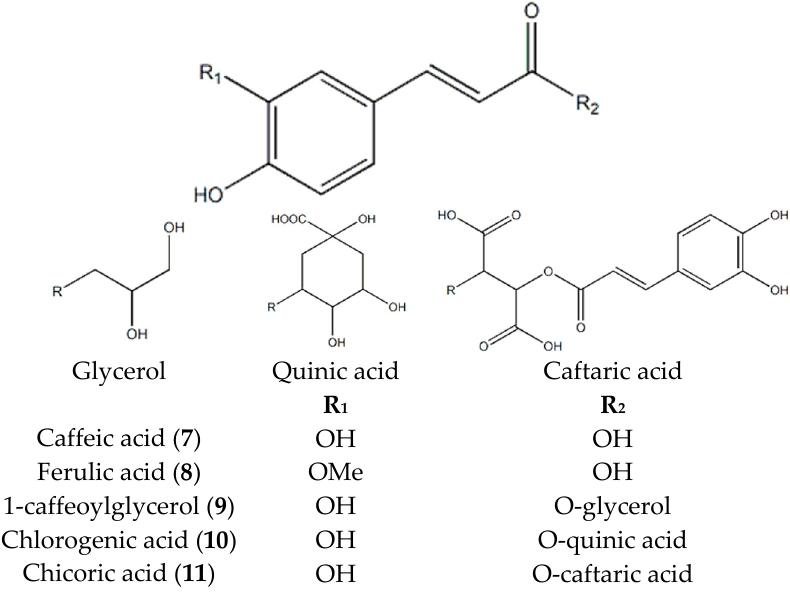
Figure 1. Structures of the compounds 1 – 11 . Table 2. Identification of compounds 1 – 11 in T. coreanum by UHPLC-ESI/LTQ-Orbitrap-HRMS analysis. Compound No.